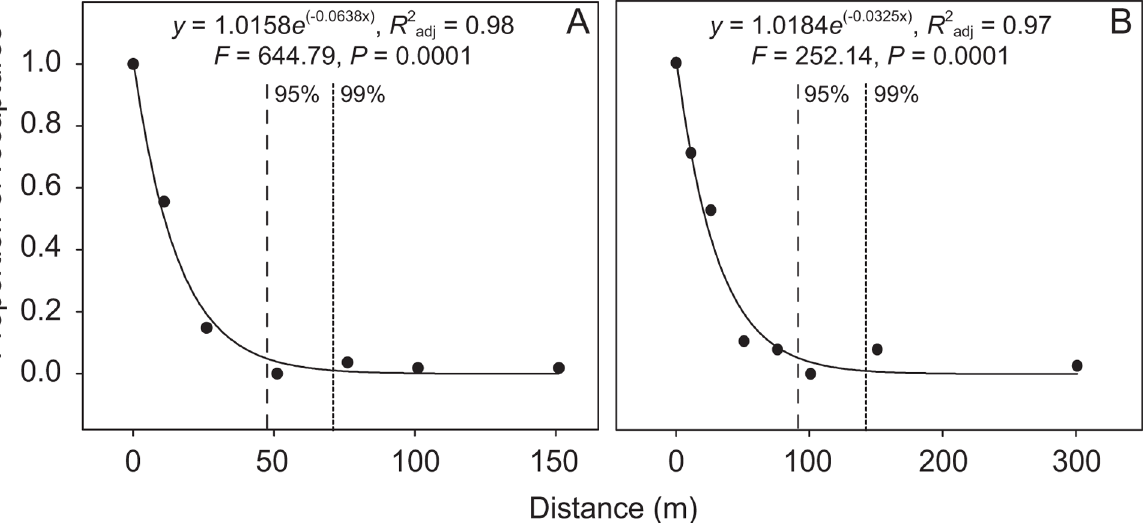
Fig 3. Proportion of recaptured Scarabaeinae with increasing distance for estimated time periods of 48 (A) and 96 h (B). Each proportion was normalized by the number of beetles recaptured in the smallest distance category (0 – 10 m). Dashed and dotted lines represent the radius for 95 and 99% of recaptured individuals, respectively. The distance is an estimate based on the distance traveled by beetles during longer